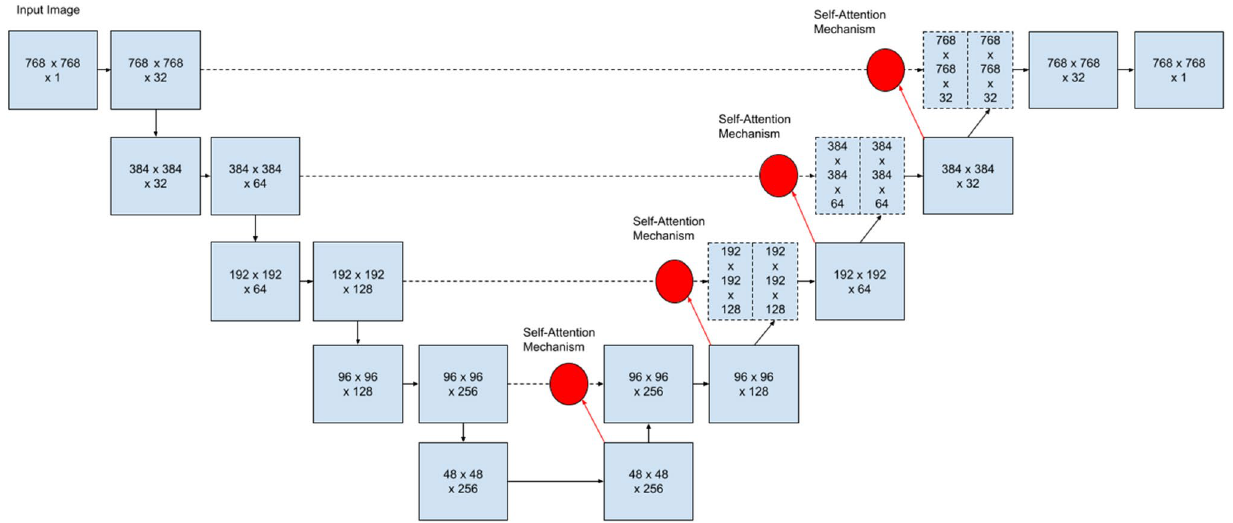
Figure 3. Illustration of the self-attended deep CNN